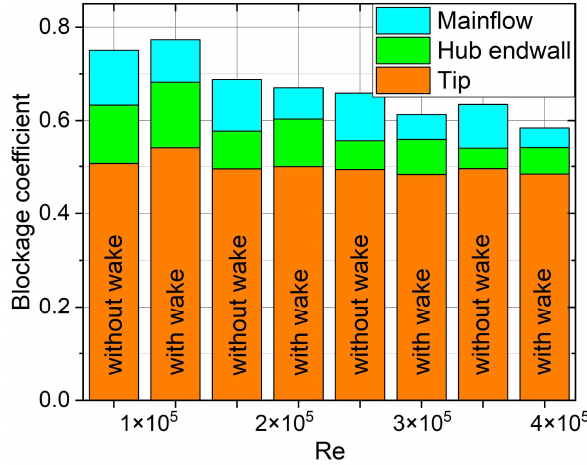
Figure 7. Comparison of blockage coefficient in three regions at the rotor outlet.